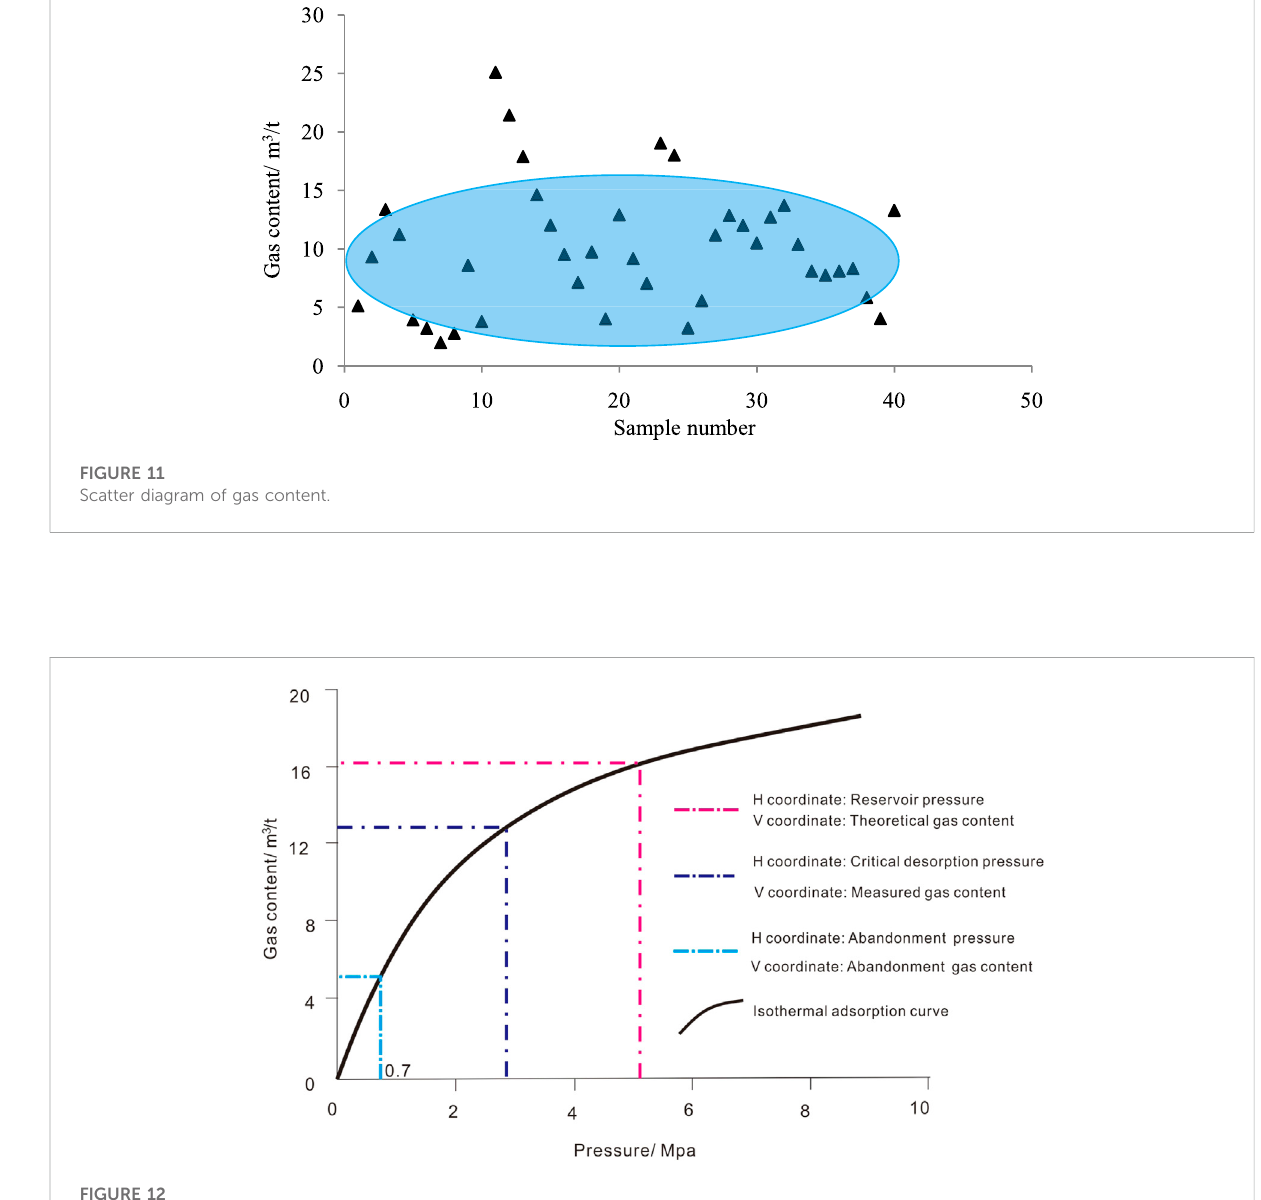
FIGURE 12 Isothermal adsorption curve and its major parameters (H: horizontal; V: